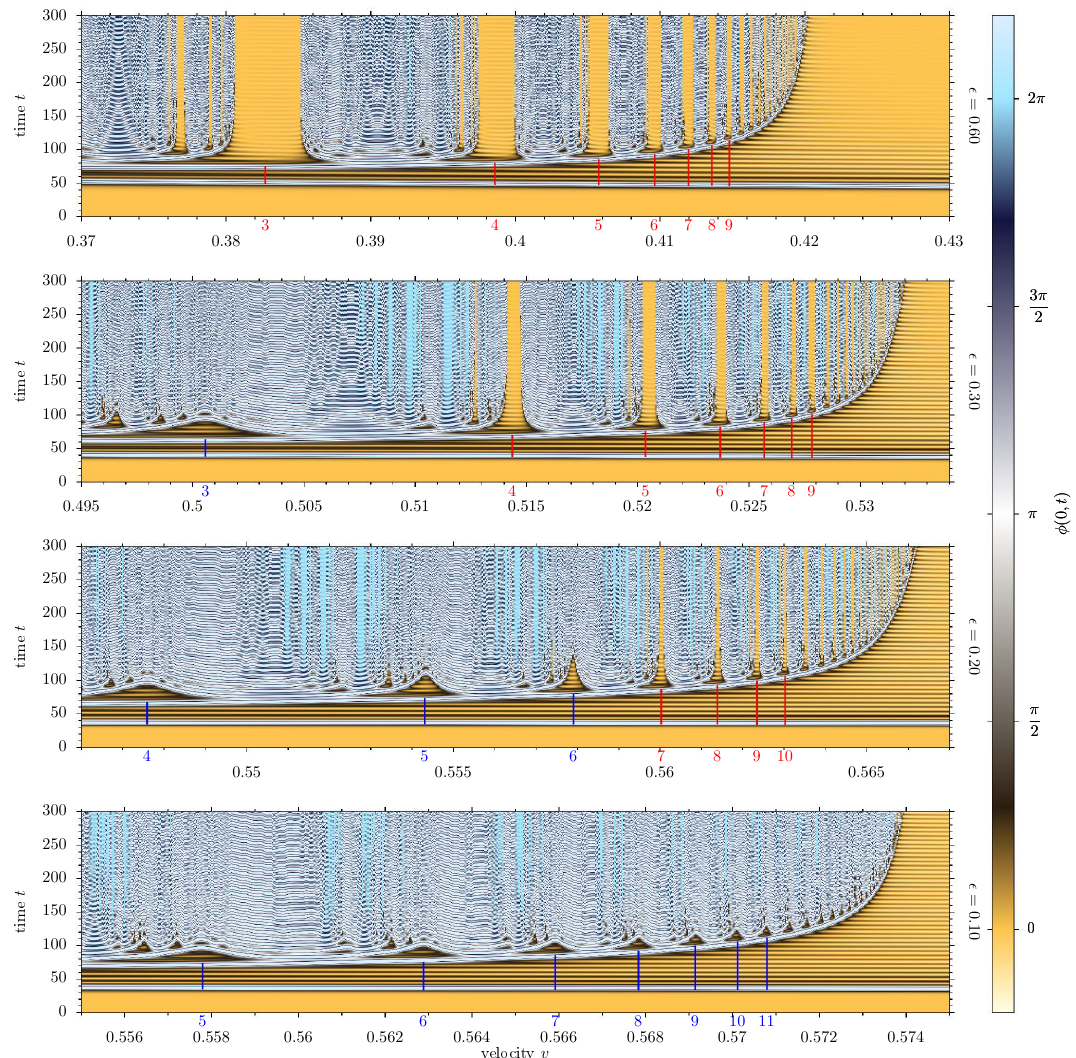
Figure 14 . Kink-antikink resonance collisions in the model (2.1) for four values of the parameter (cid:15) in regime 1. The plots show the field value at the collision centre as a function of initial velocity v and time t from the start of the simulation. As (cid:15) decreases, the windows move to higher velocities, and some change from true windows to false windows. The window numbers are shown in red and blue below the plots; blue for false windows, and red for true